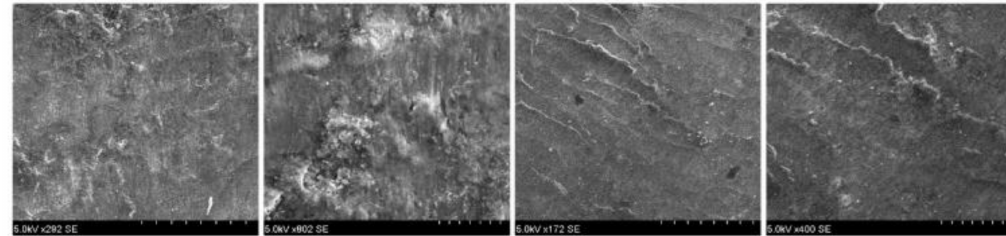
Figure 5. Microscopic appearance of the enamel after removal of the ceramic brackets 6.0 kV.